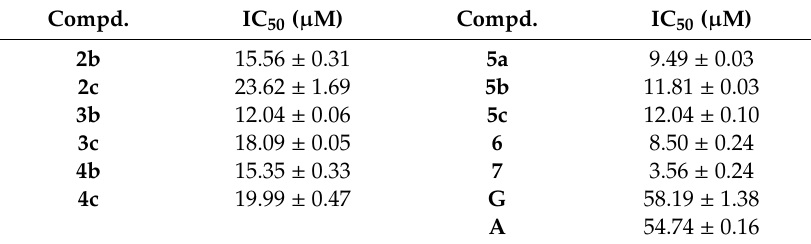
Table 1. α -Glucosidase (EC 3.2.1.20) inhibition of highly active compounds in vitro. Compd. IC 50 ( µ M) Compd.